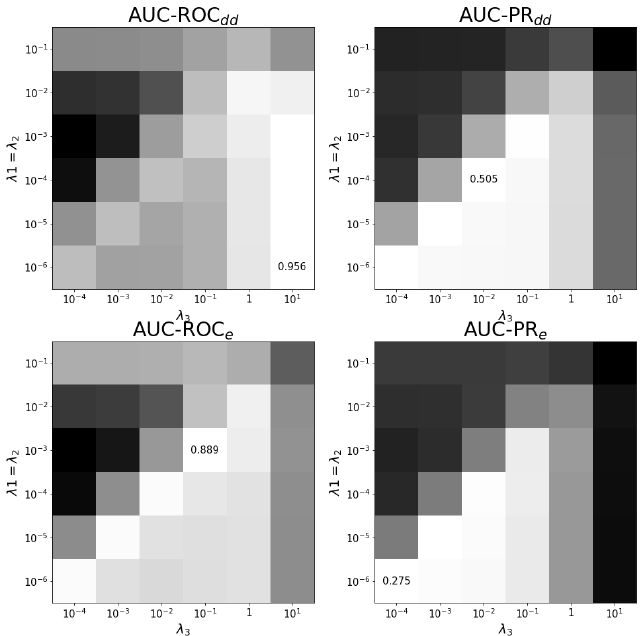
Figure A1. Tuning regularization parameters for task (cid:100) dde . The average performance on ten training folds using shortcuts for leave-out validation is shown for different combinations of regularization parameters. The optimal combination and values are shown. White corresponds to the highest per- formance and black to the lowest performance. Each panel has a different color scale as performance varies over different